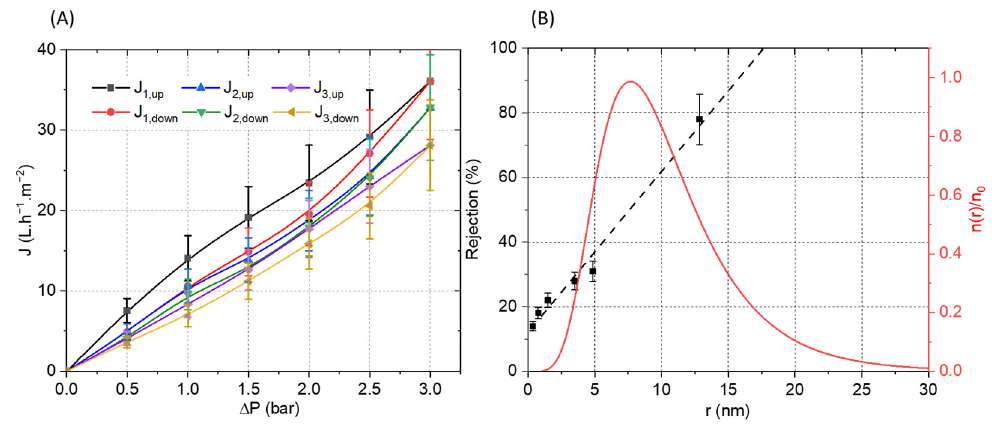
Figure 10. ( A ) Pressure increase and decrease cycles of water permeation experiment with the PVDF-supported membrane. ( B ) Polyethylene glycol (PEG) rejection coefficient (R) vs. the Einstein–Stokes radius of the solute (PEG) (black). Log-normal pore size distribution: reduced number of pores per unit of area n(r)/n 0 vs. the pore radius (red).